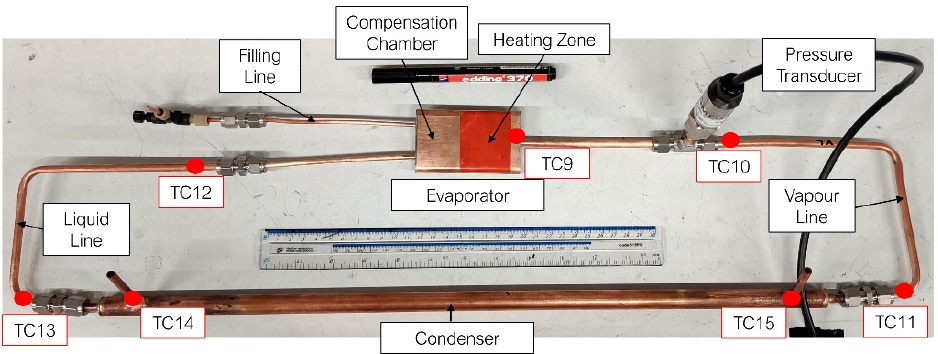
Figure 4. Copper/copper LHP used in the present investigation noted with parts description and thermocouple numbering and positioning. Table 3. Geometry of the LHP used in the present investigation (all parts are made in copper).